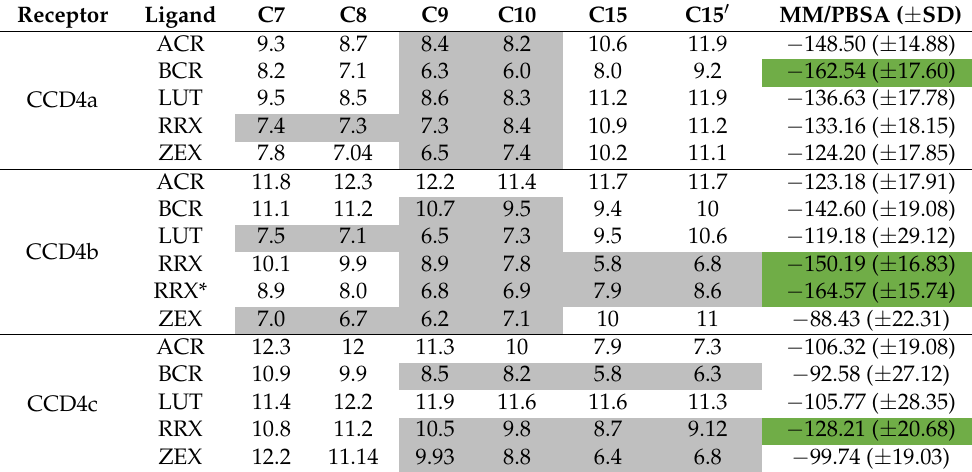
Table 4. Values of the distances between the C7, C8, C9, C10, C15, and C15 (cid:48) carbon atoms of each carotenoid and the Fe +2 ion. Lower distance values are highlighted in grey. In the last column, binding free energy values, evaluated by the MM/PBSA method, are reported in kJ/mol units. Best binding energy values are highlighted in green. RRX* indicates the results obtained by extending the MD trajectory of the CCD4b–RRX complex to 1 µ